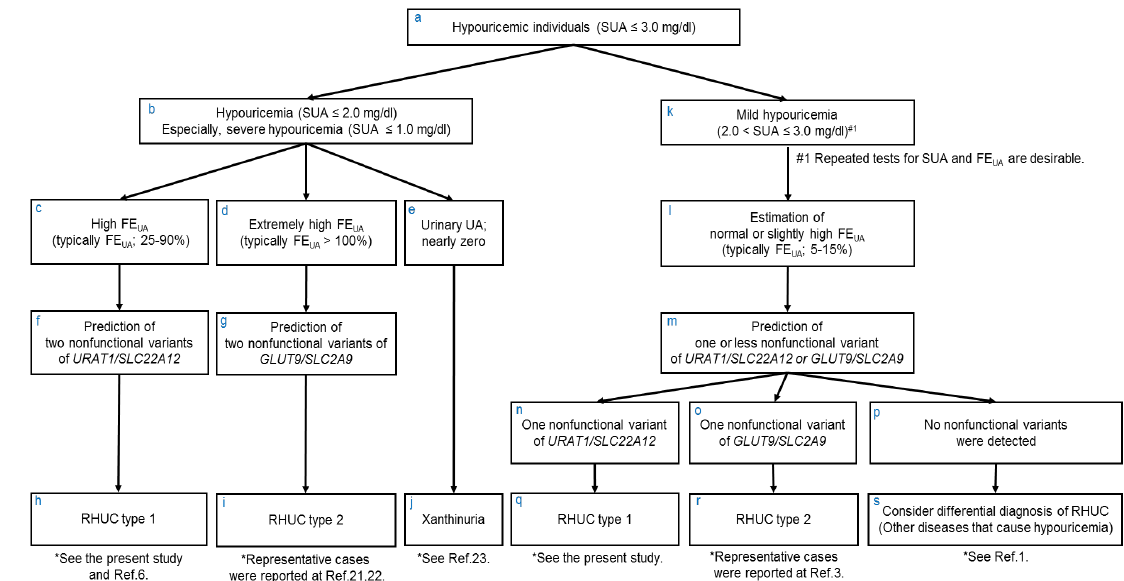
Figure 3. Flowchart to predict the number of nonfunctional variants of causative genes for RHUC based on FE UA and SUA data. Based on the findings of the present study, together with previous reports, we hereby propose a method of making a more practical diagnosis of RHUC even before genetic testing for URAT1/SLC22A12 or GLUT9/SLC2A9 , when physicians detect and examine hypouricemic individuals (SUA ≤ 3.0 mg /dL; ( a ) ). In those with hypouricemia (SUA ≤ 2.0 mg /dL), especially with severe hypouricemia (SUA ≤ 1.0 mg /dL) ( b ), their FE UA and urinary UA data should be investigated ( c – e ). These data will help to estimate RHUC type 1 or 2 due to two nonfunctional variants of URAT1 or GLUT9 , or xanthinuria ( f – j ). Genetic analysis is needed to distinguish RHUC type 1 and type 2, but this flowchart shows that physicians should be able to predict the causative gene from patients’ laboratory data before performing a genetic analysis. On the other hand, in those with mild hypouricemia (2.0 < SUA ≤ 3.0 mg/dL; ( k )), their FE UA data are estimated to be normal or slightly high ( l ), which makes it possible to predict there to be one or no nonfunctional variants of URAT1 or GLUT9 ( m ). With these mild hypouricemia patients, detection of one nonfunctional variant of URAT1 ( n ) or GLUT9 ( o ) by genetic analysis is needed to make a diagnosis of RHUC type 1 ( q ) or type 2 ( r ). Physicians should consider differential diagnosis of RHUC ( s ) if no nonfunctional variants of URAT1 or GLUT9 are detected ( p ). Additionally, see Figure 4 regarding the patterns of FE UA and SUA data of RHUC type 1 and type 2. SUA, serum uric acid; FE UA , fractional excretion of uric acid; UA, uric acid; RHUC, renal